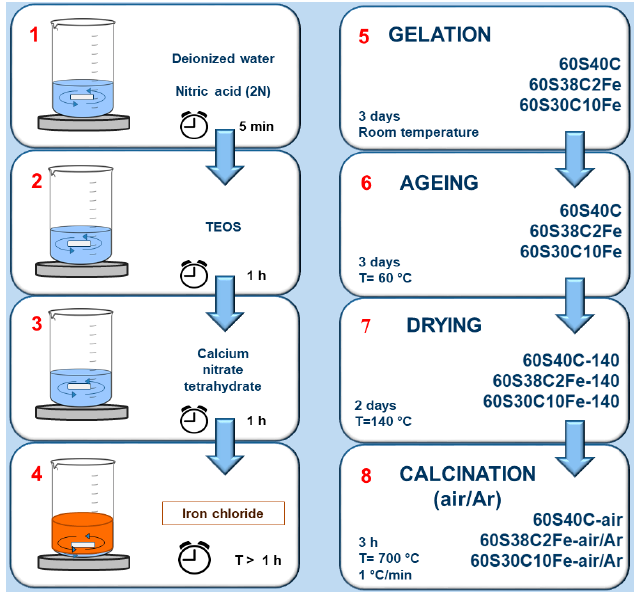
Figure 1. Scheme of the eight-stage synthesis process adopted to produce the materials investigated in this work.